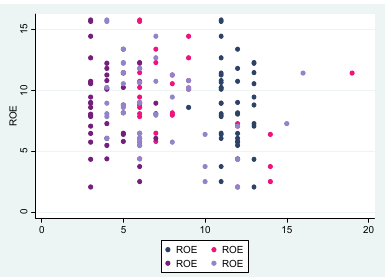
Fig. 1. The results of Pearson correlation between